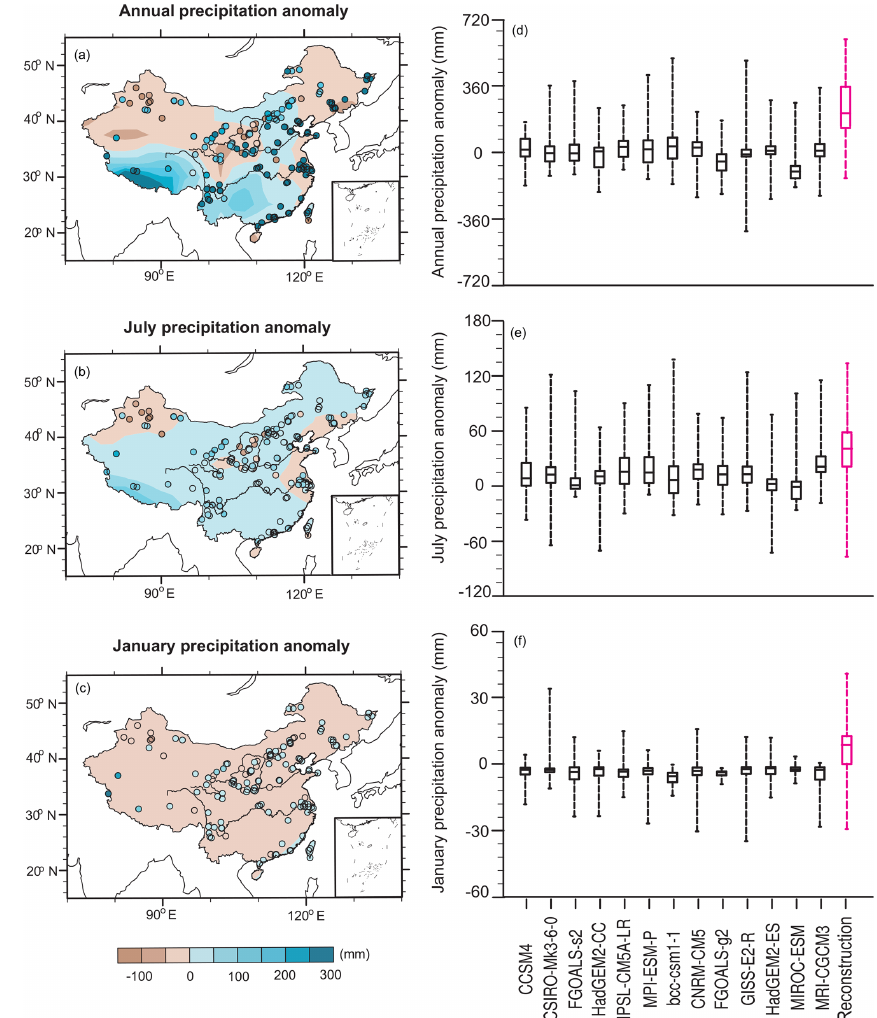
Figure 4. Model–data comparison for annual, July and January precipitation (mm). For (a, b) , points represent the reconstruction from IVM, and shading shows the last 30-year mean simulation results of a multi-model ensemble (MME) for 13 PMIP3 models. The box-and-whisker plots (d–f) show the changes as indicated by each PMIP3 model and the reconstruction. (d) Changes in annual precipitation, (e) changes in July precipitation and (f) changes in January precipitation. The lines in each box show the median value from each set of measurements, the box shows the 25%–75% range and the whiskers show the 90% interval (5th to 95th